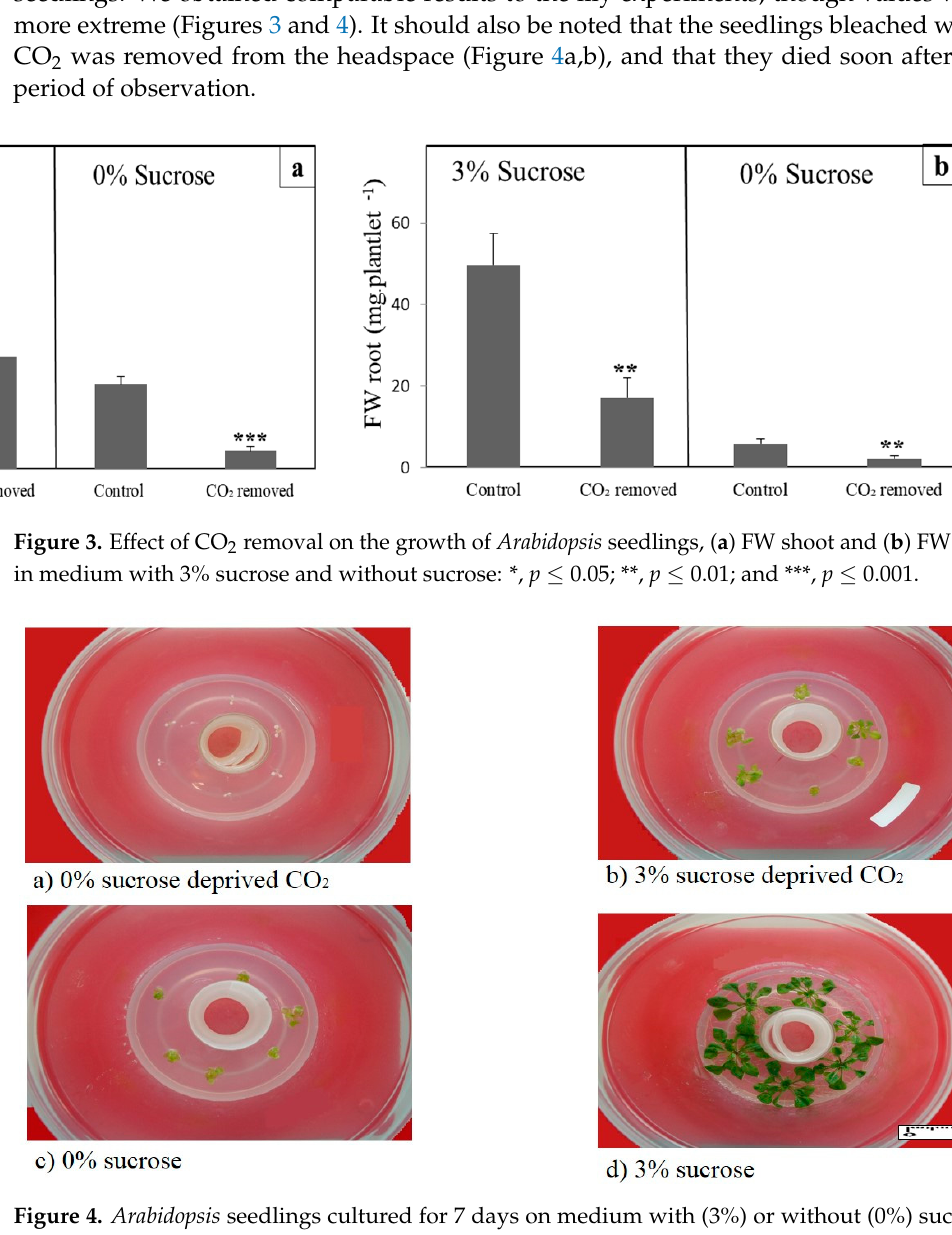
Figure 2. Effect of CO 2 removal on lily growth: bulblets ( a ), leaves ( b ), roots ( c ), and scale explants ( d ) in medium with 3% sucrose or without sucrose. *, p ≤ 0.05 and **, p ≤ 0.01.